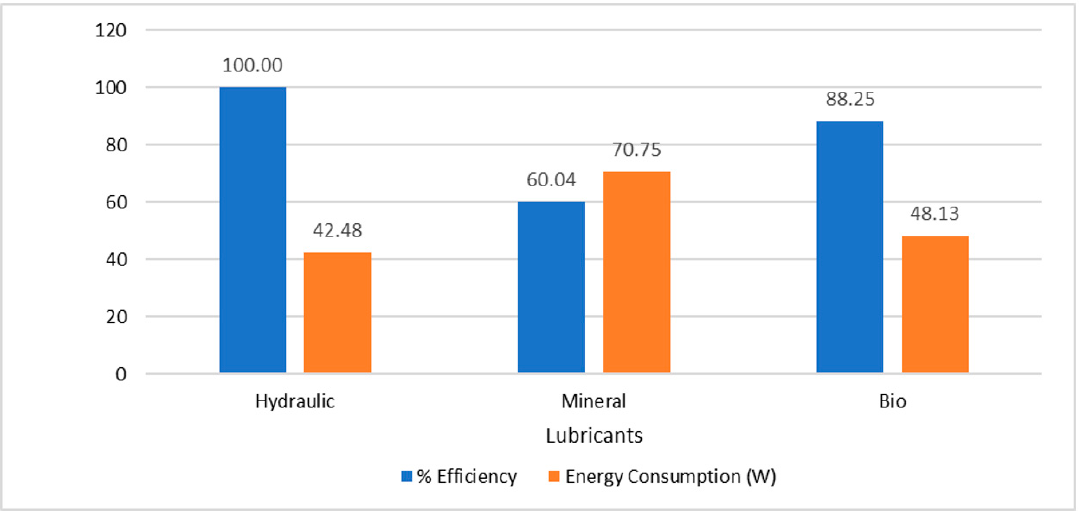
Figure 10. Energy consumption and % efficiency results.